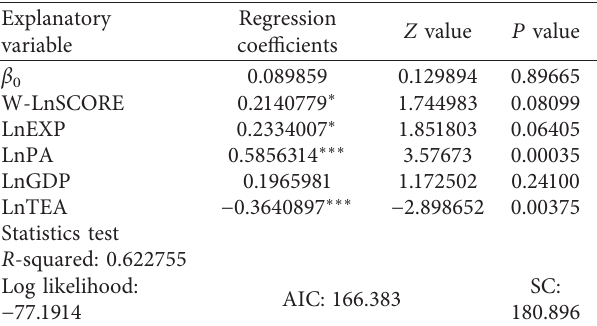
Table 4: Results of spatial econometric regression based on cross- section data in